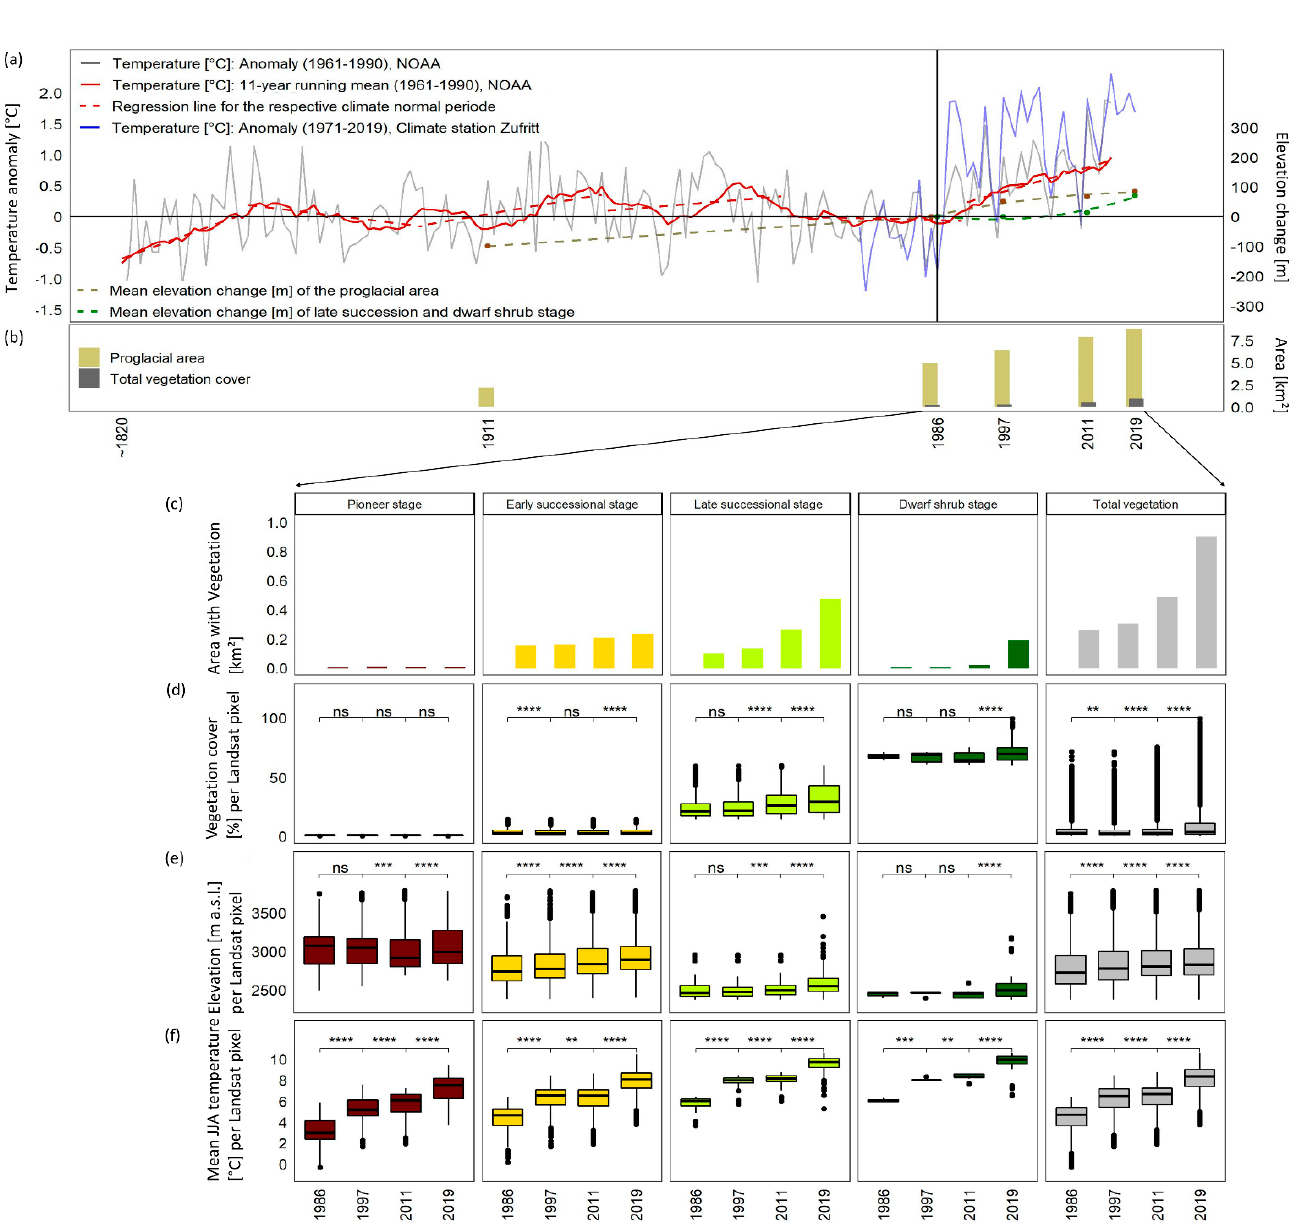
Figure 5. Temporal development of glacier forelands and primary succession under the aspect of global warming. The temperature development ( a ) is shown as long-term temperature anomaly (1961–1990; annually; 11-year running mean; regression line for each climate normal period) based on the NOAA time series (1836–2015) and as annual temperature anomaly (1973–1990) for the Zufritt weather station (1973–2019; upper Martell Valley, 46.51°N, 10.73°E; 1851 m a.s.l.) (left y-axis). Based on the determined temperature lapse rate ( − 0.0048 K/m), the respective elevation change [m] is shown for the temperature (right y-axis). Further, the mean elevation change of the proglacial area and the vegetation cover (late successional and dwarf shrub stage) are visualized. The development of the ( b ) proglacial area (km 2 ) and the total vege- tation cover (km 2 ) are shown as bar diagrams. Primary succession is shown as ( c ) bar diagram, indicating the area (km 2 ). Statistical relations between the observed years are visualized as boxplots for the ( d ) mean vegetation cover (%), ( e ) mean elevation (m a.s.l.) and ( f ) mean JJA temperature (°C) of the respective vegetation successional stage according to the Landsat pixel (30 m × 30 m). The statistical analyses are shown for each successional stages and the total vegetation cover (grey). The statistical relations are indicated as asterisks (n.s. = not significant, * p < 0.05, ** p < 0.01, *** p < 0.001, **** p < 0.0001).